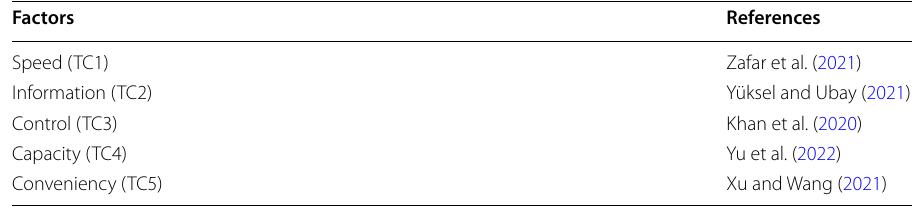
Table 2 TRIZ-based technical characteristics for financial services Factors